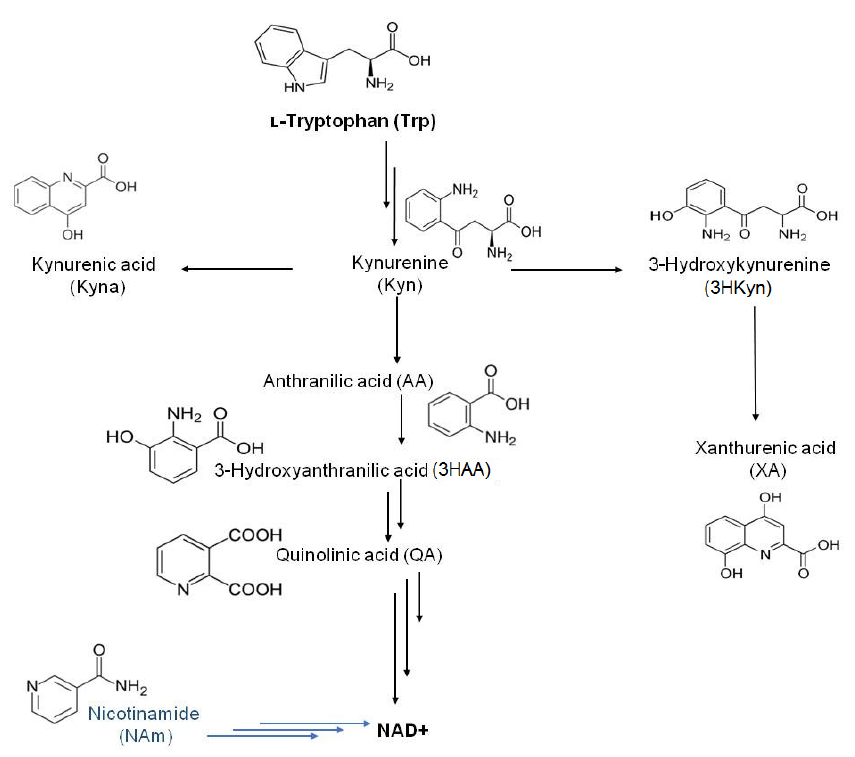
Figure 1. Biomolecules covered in this work.